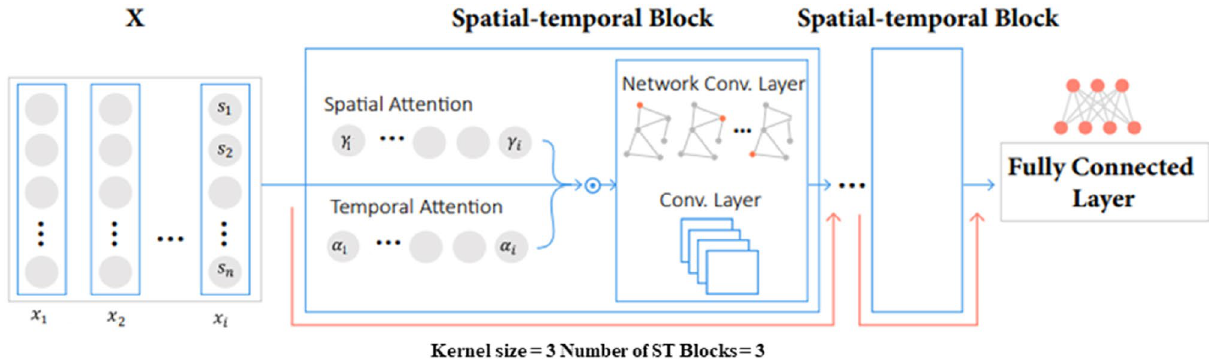
Figure 4. Model architecture, including model input, spatial–temporal blocks, attention layers, and the fully connected layer at the